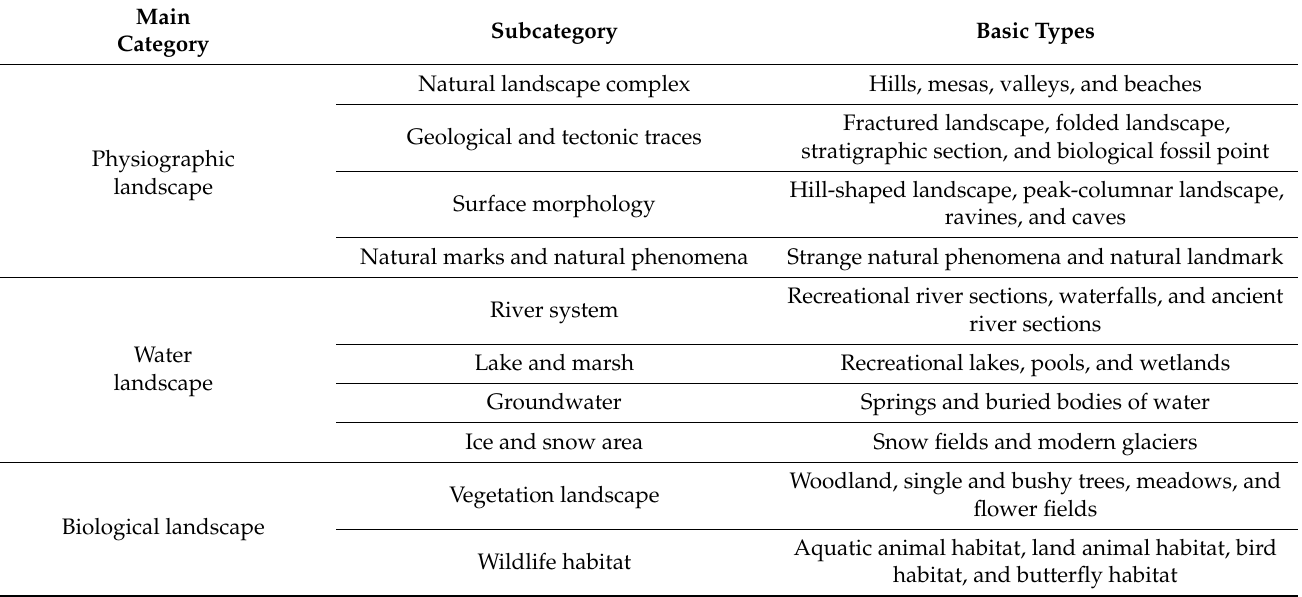
Table 2. Classification of landscape